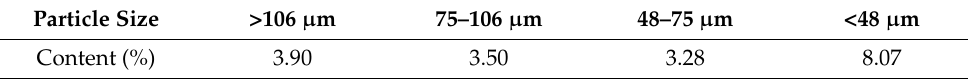
Table 2. The content of Na 2 O in red mud with different particle sizes.